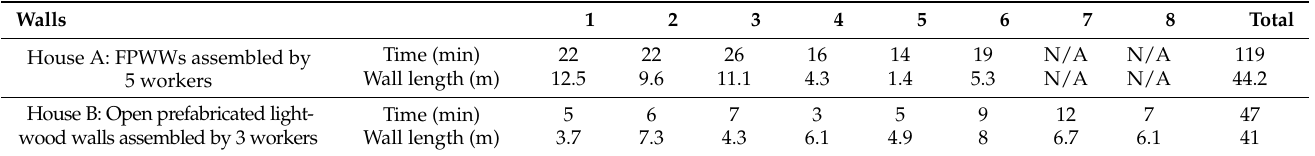
Table 6. Speed of assembly of 8 prefabricated walls for one story of House A and House B.